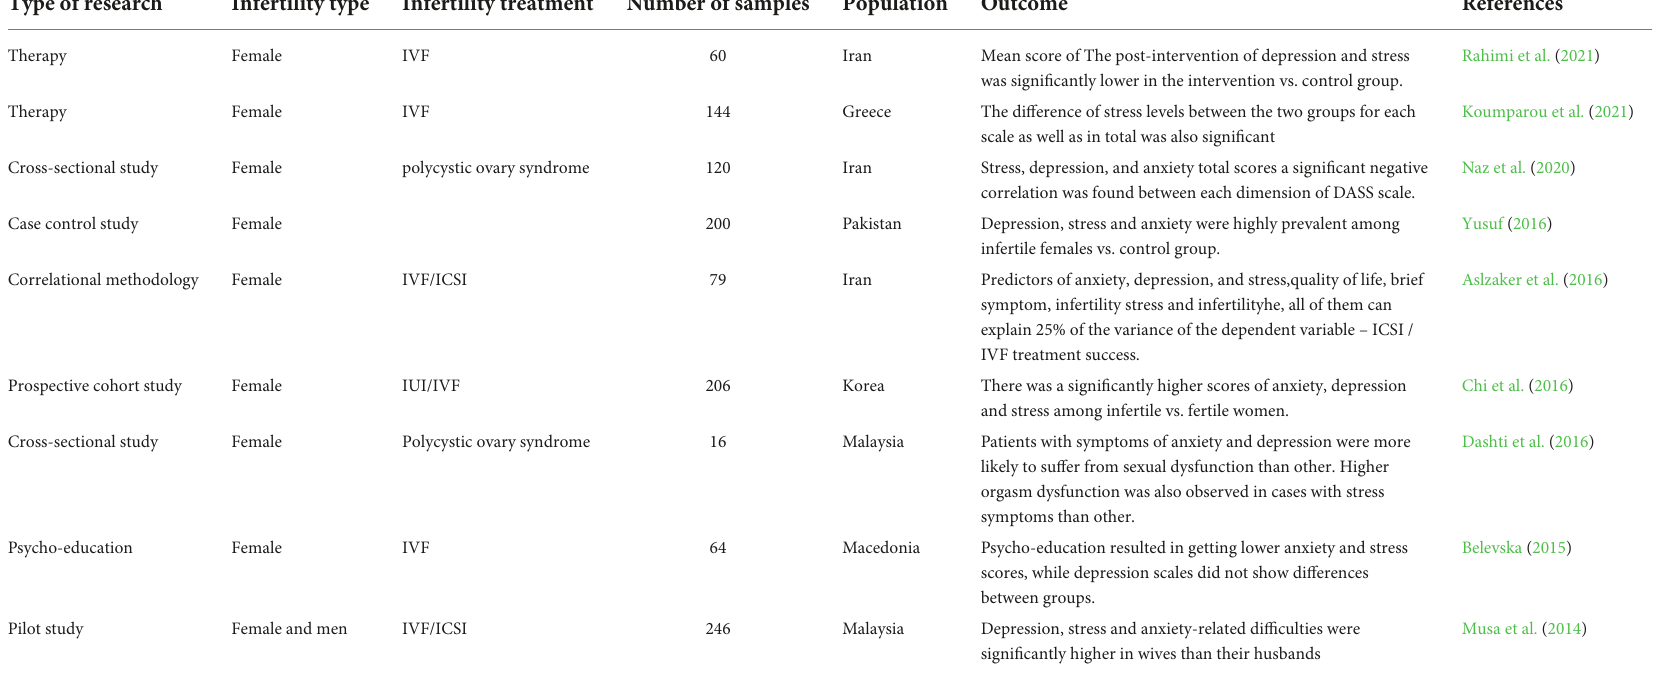
TABLE 3 DASS assessment studies in